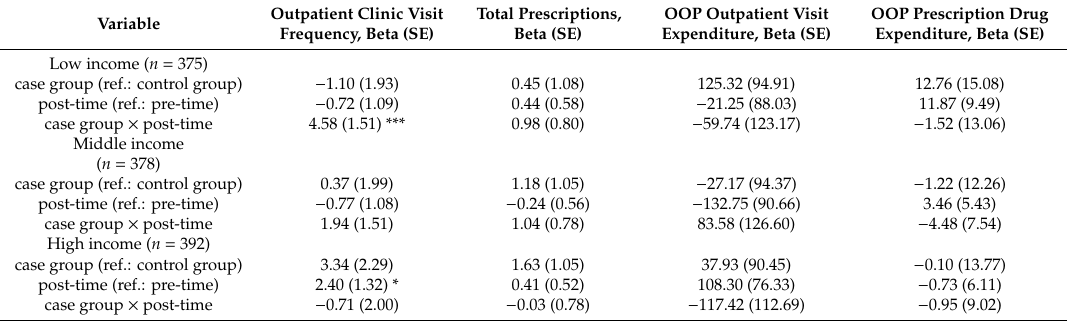
Table 4. Results of the DID analysis 1 for outpatient clinic visit frequency, total prescriptions, OOP outpatient visit expenditure, and OOP prescription drug expenditure by household